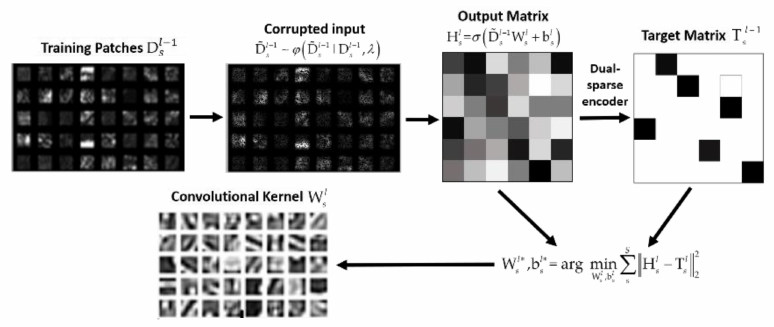
Figure 4. The model structure of the denoising dual-sparse encoder.